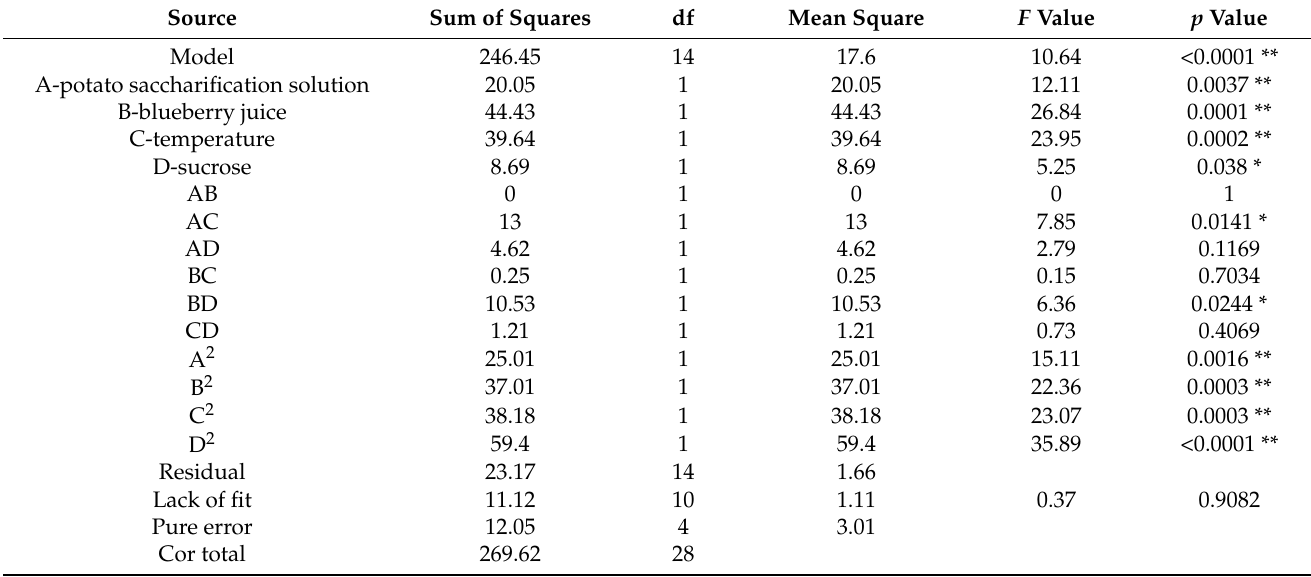
Table 6. ANOVA of response surface.